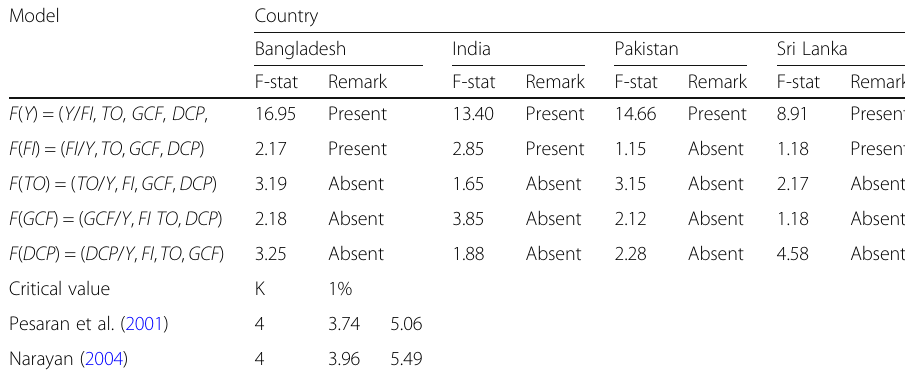
Table 3 ARDL bound testing